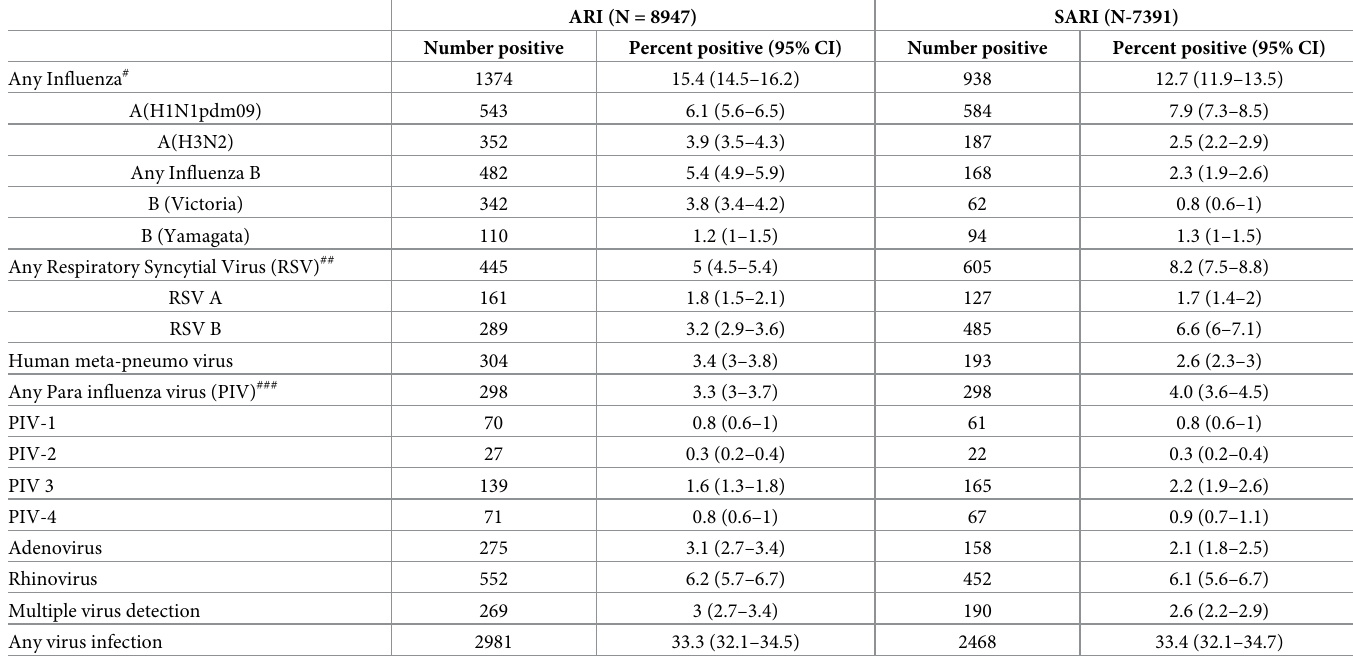
Table 3. Virus detection among cases of acute respiratory infection (ARI) and severe acute respiratory infection (SARI), India